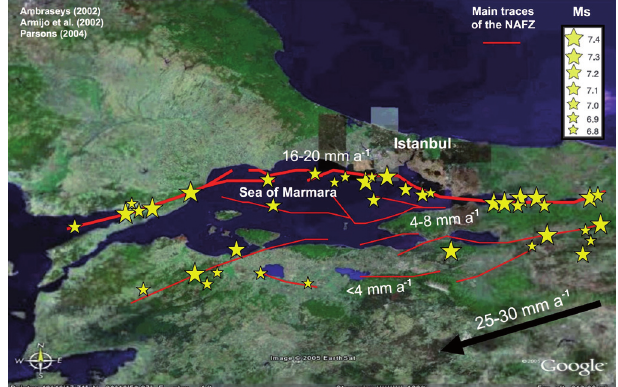
Figure 2. Proposed drilling location on the is- land of Sivriada that is located in direct vicin- ity to the main branch of the